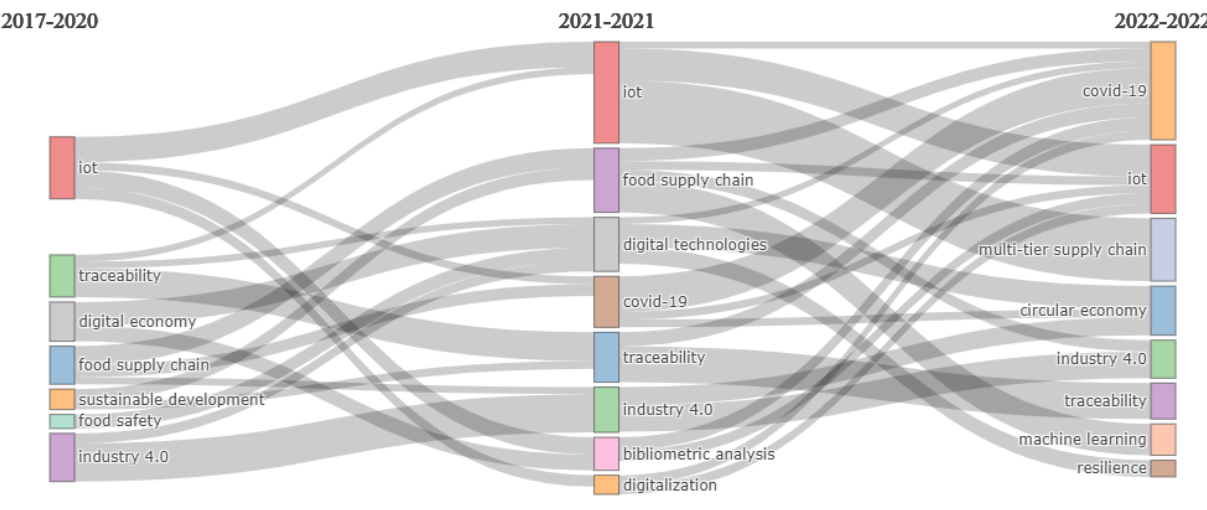
Figure 5. Thematic Evolution Map (2017 – 2022).